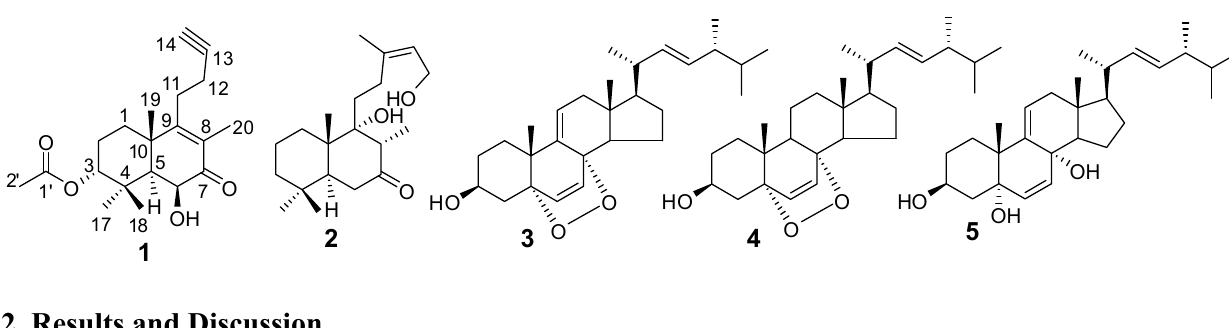
Figure 1. Structures of compounds 1 – 5